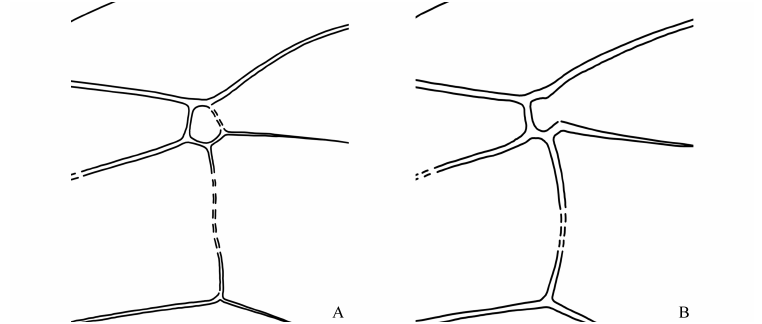
Fig. 1. Detail of areolet (fore wing). A . Distictus tibialis (Brullé, 1846). B . Mallochia sp. Redrawn after Townes (1970: figs 146 and 243b,